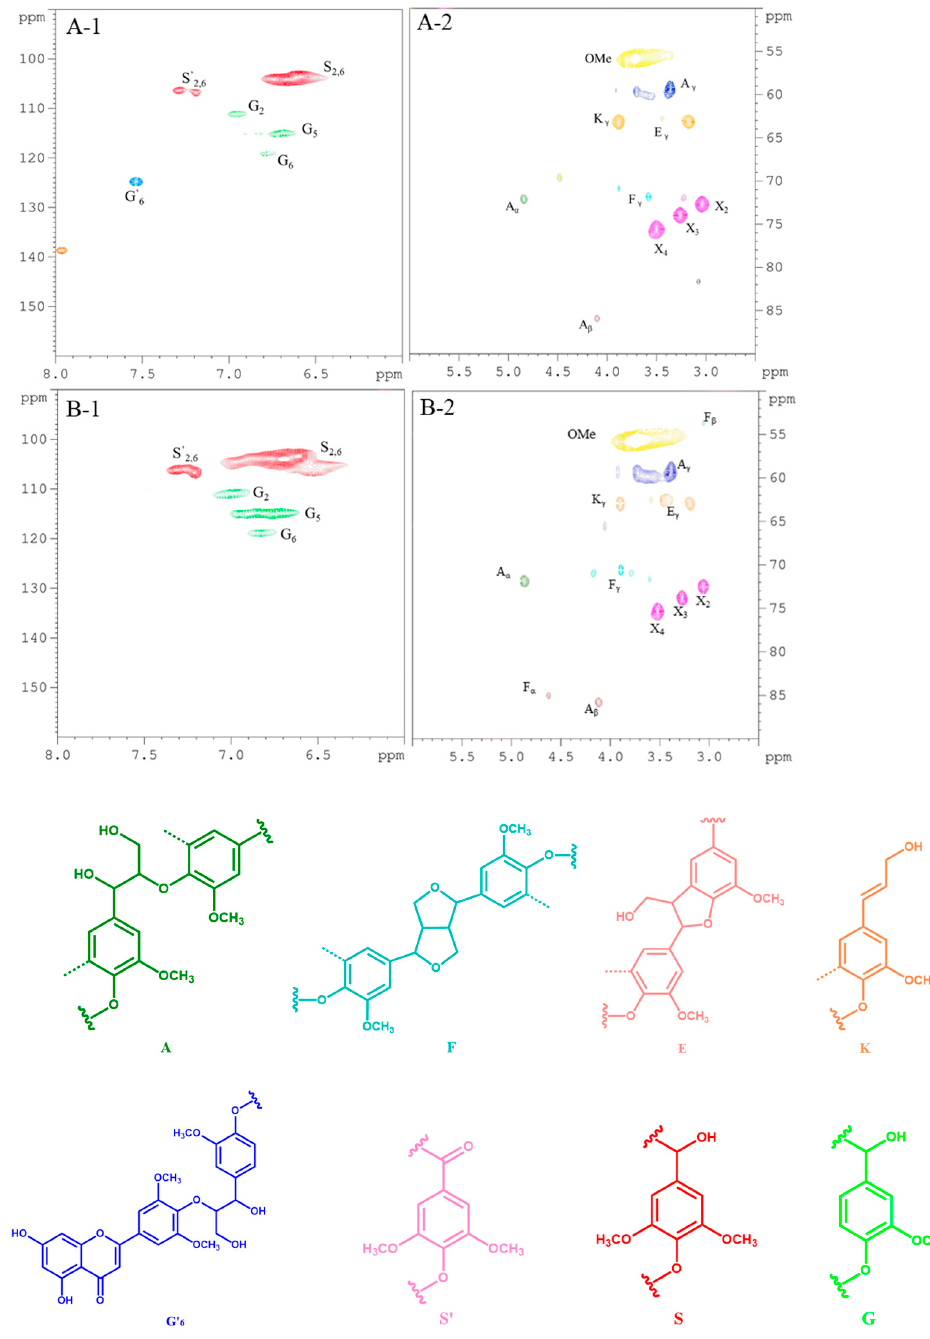
Figure 8. 2–D HSQC NMR and corresponding structural analysis with aromatic region (1) and aliphatic region (2) of lignin at T150A14t0 (A) and T150A14t60 (B).